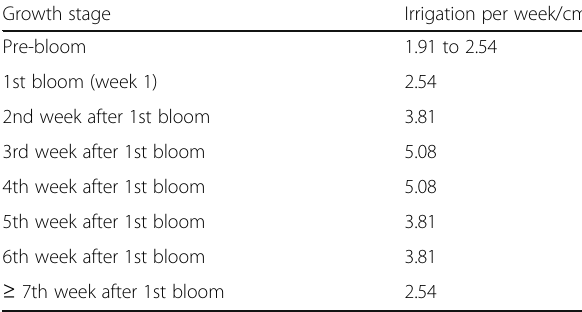
Table 1 Typical checkbook schedule (UGA Extension Recommendation) for cotton irrigation in Georgia (Collins et